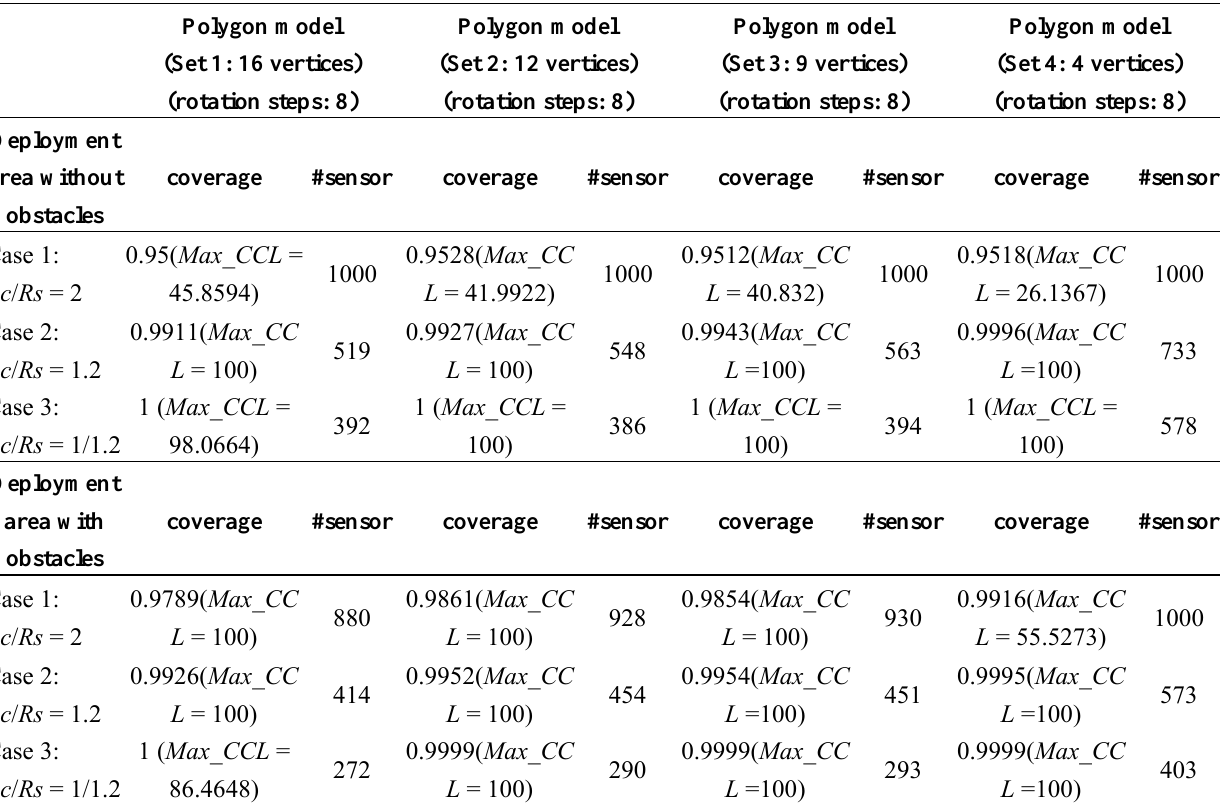
Table 9. The maximum sensing coverage rates and the usage of sensor nodes in Simulation